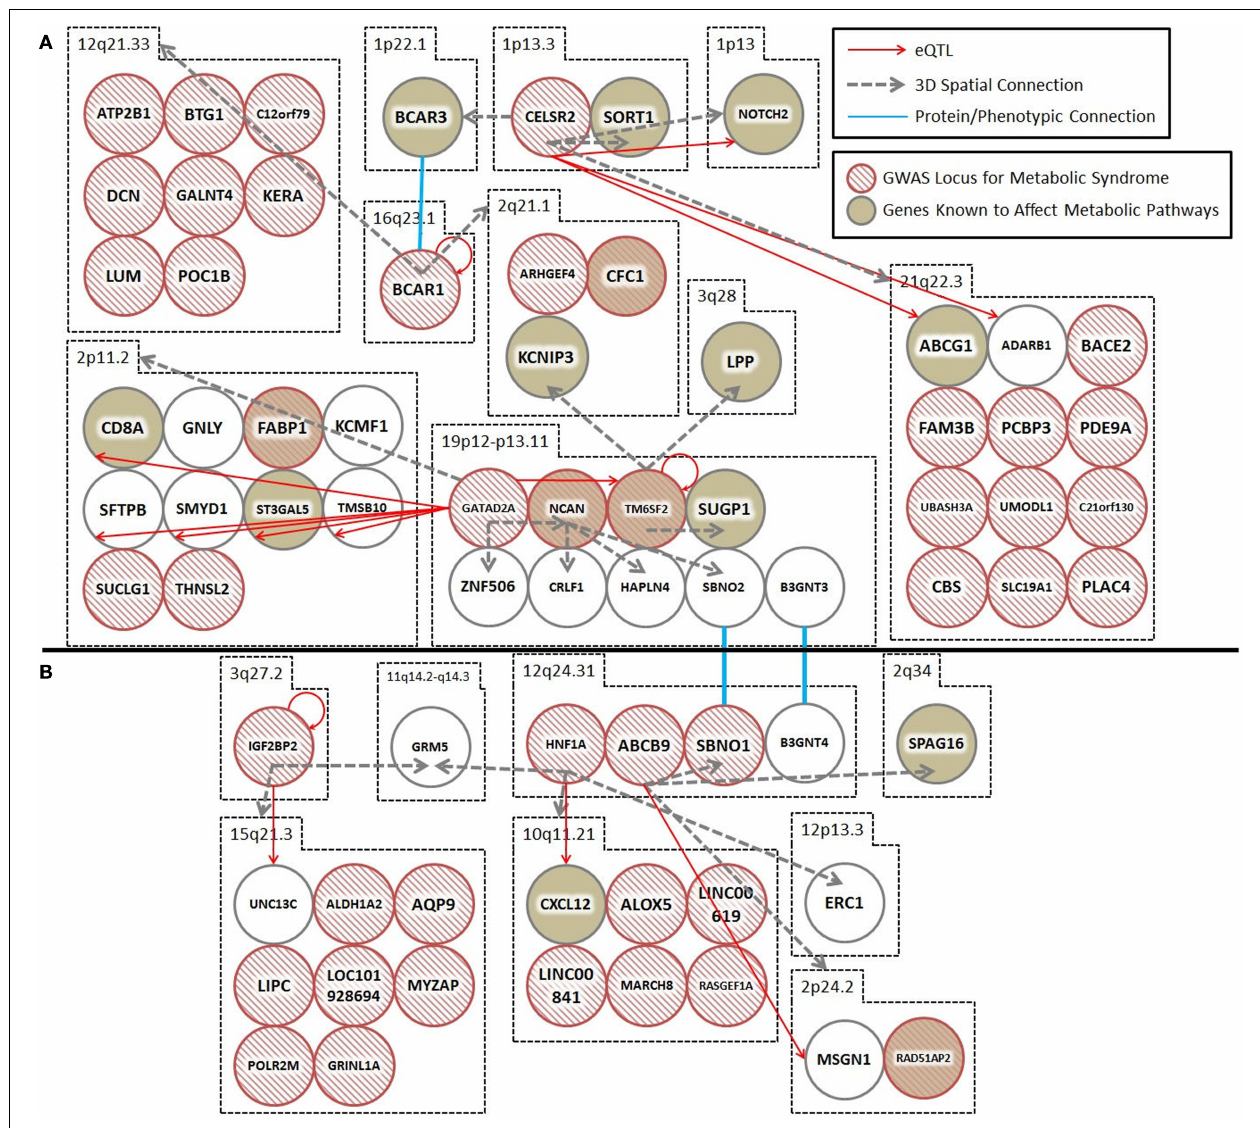
were identified by GWAS as being important for T2D and the metabolic syndrome are represented by hashed red circles. Loci in biological pathways related to T2D or metabolic syndrome are represented by tan filled loci. Protein/phenotype connections (blue lines) are illustrated where appropriate to connect relevant loci and further expand the regulatory co-interaction diagram. For example, (1) spatial associations with KCNIP3 (2q21) and a physical connection between the BCAR1–BCAR3 proteins link TM6SF2, CTRB1–BCAR1, and CELSR2–PSRC1, into a spatial hub and (2) GRM (11q14) links the IGF2BP2 locus (3q27) to the HNF1A locus (12q24) together along with other loci that have been previously implicated in diabetes. (A,B) illustrate two spatial hubs that are connected by functional linkages between SBNO1-SBNO2 and B3GNT3-BGNT4. *For the sake of clarity, the following loci were abbreviated: CELSR2, CELSR2/PSRC1; BCAR1, CTRB1/BCAR1; GATAD2A, GATAD2A/TSSK6/NDUFA13/YJEFN3/CILP2;